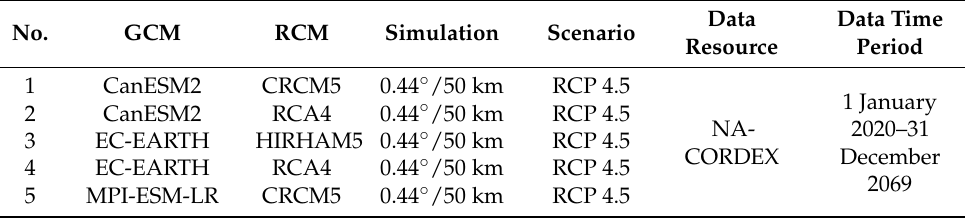
Table 2. Global climate model (GCM) and regional climate model (RCM) combinations. No. GCM RCM Simulation Scenario